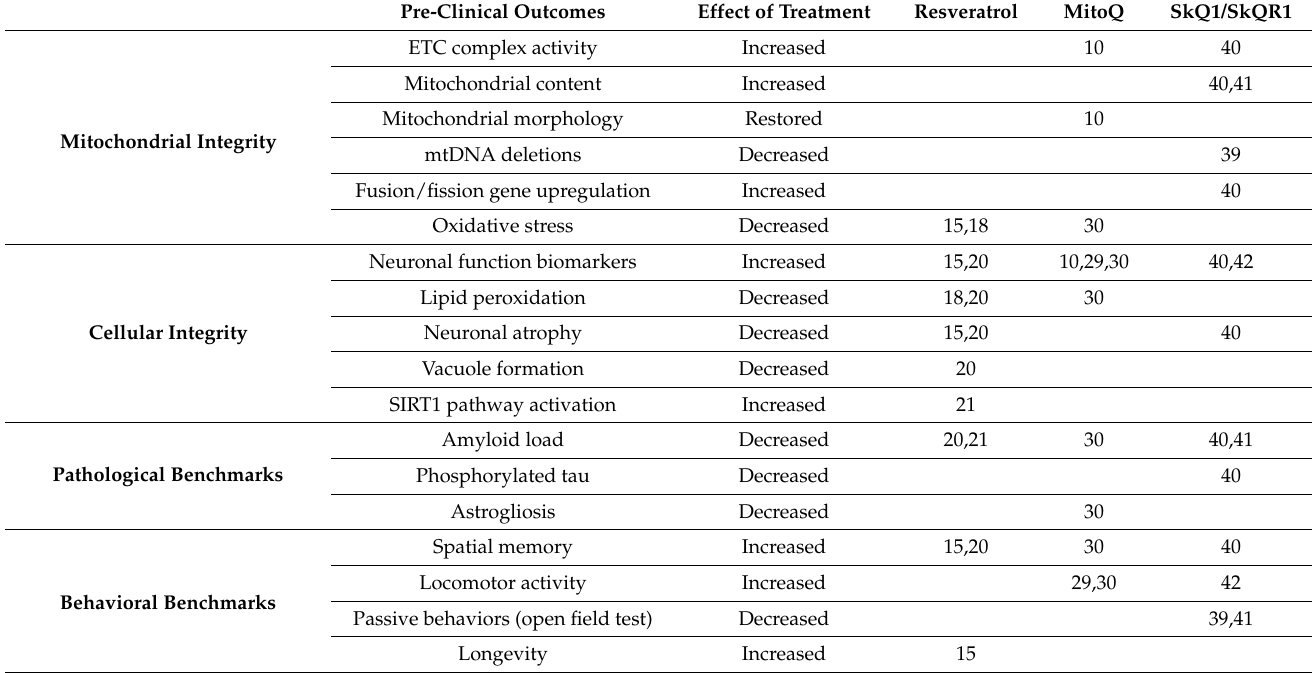
Table 1. Outcomes, by reference number, of resveratrol, MitoQ and SkQ1/SkQR1 treatment in pre-clinical